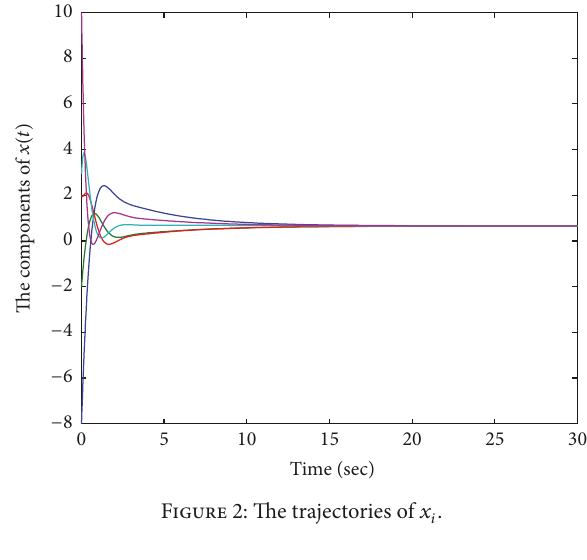
Figure 1: Connected graph.